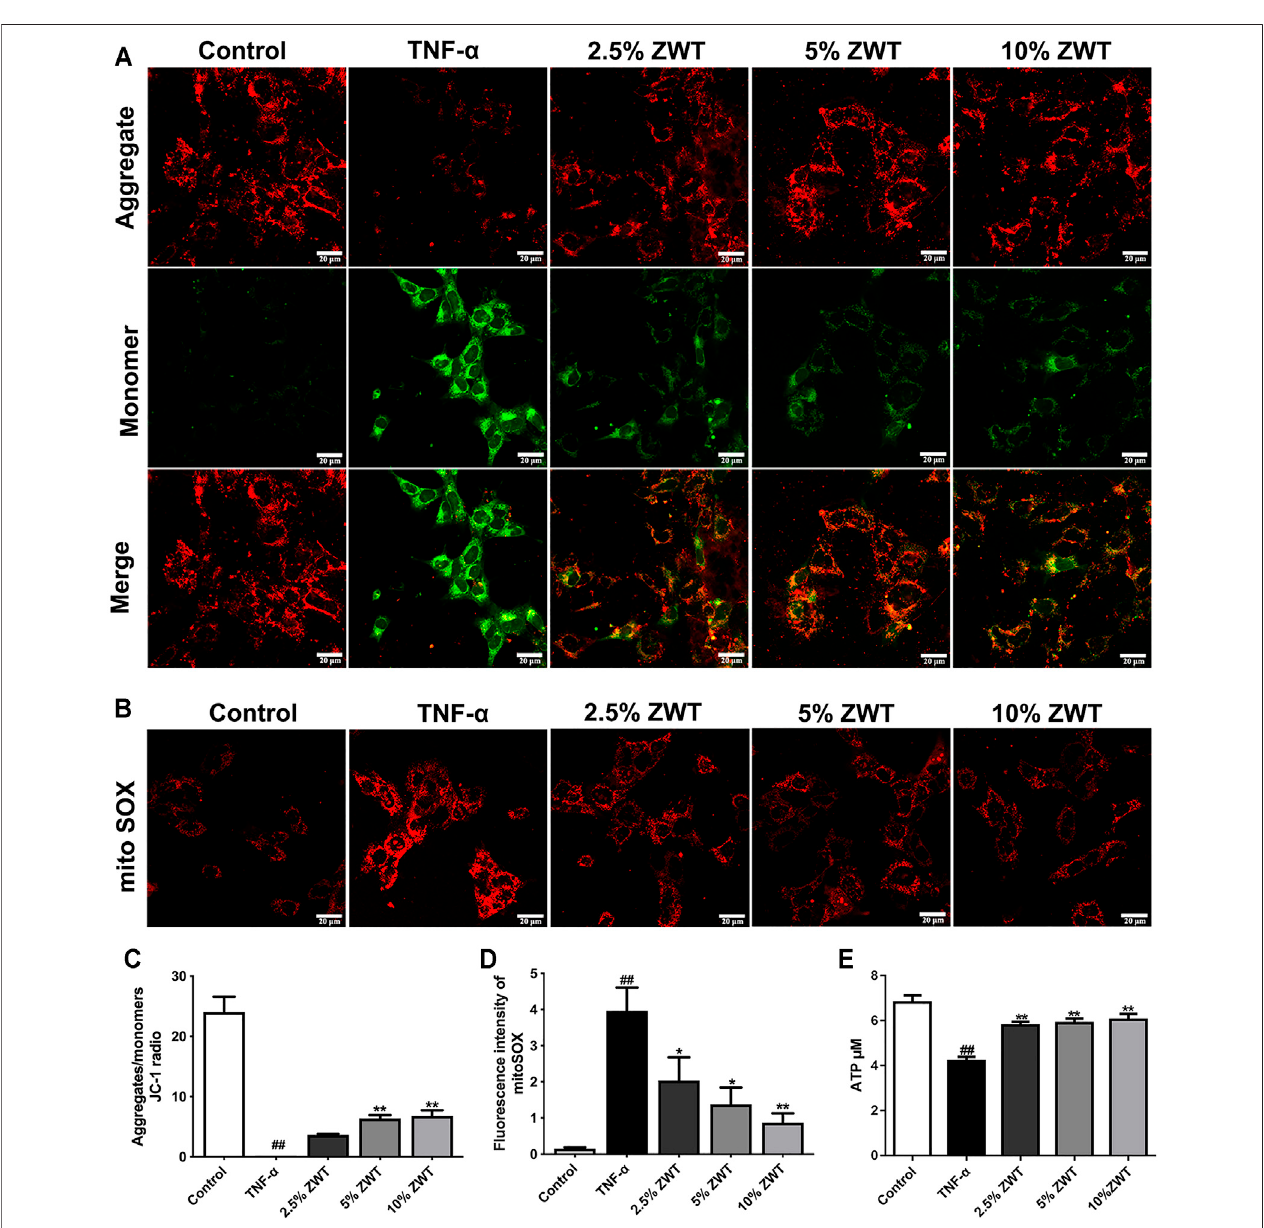
FIGURE5| ZWTalleviatedmitochondrialdysfunctioninpodocyte. (A) Representativeimagesofmitochondrialmembranepotentialinpodocytes( × 400,scalebar (cid:2) 20 μ m). (B) Representative images of mitoSOX in podocytes ( × 400, scale bar (cid:2) 20 μ m). (C) The ratio of aggregates/monomers of JC-1 probe. (D, E) The fl uorescence intensityofmitoSOX,ATPlevelsinpodocytes.Dataareexpressedasmean ± SD, n (cid:2) 3. # p < 0.05, ## p < 0.01versuscontrolgroup,* p < 0.05and** p < 0.01versusTNF- α group. ZWT promoted mitophagy in podocytes.